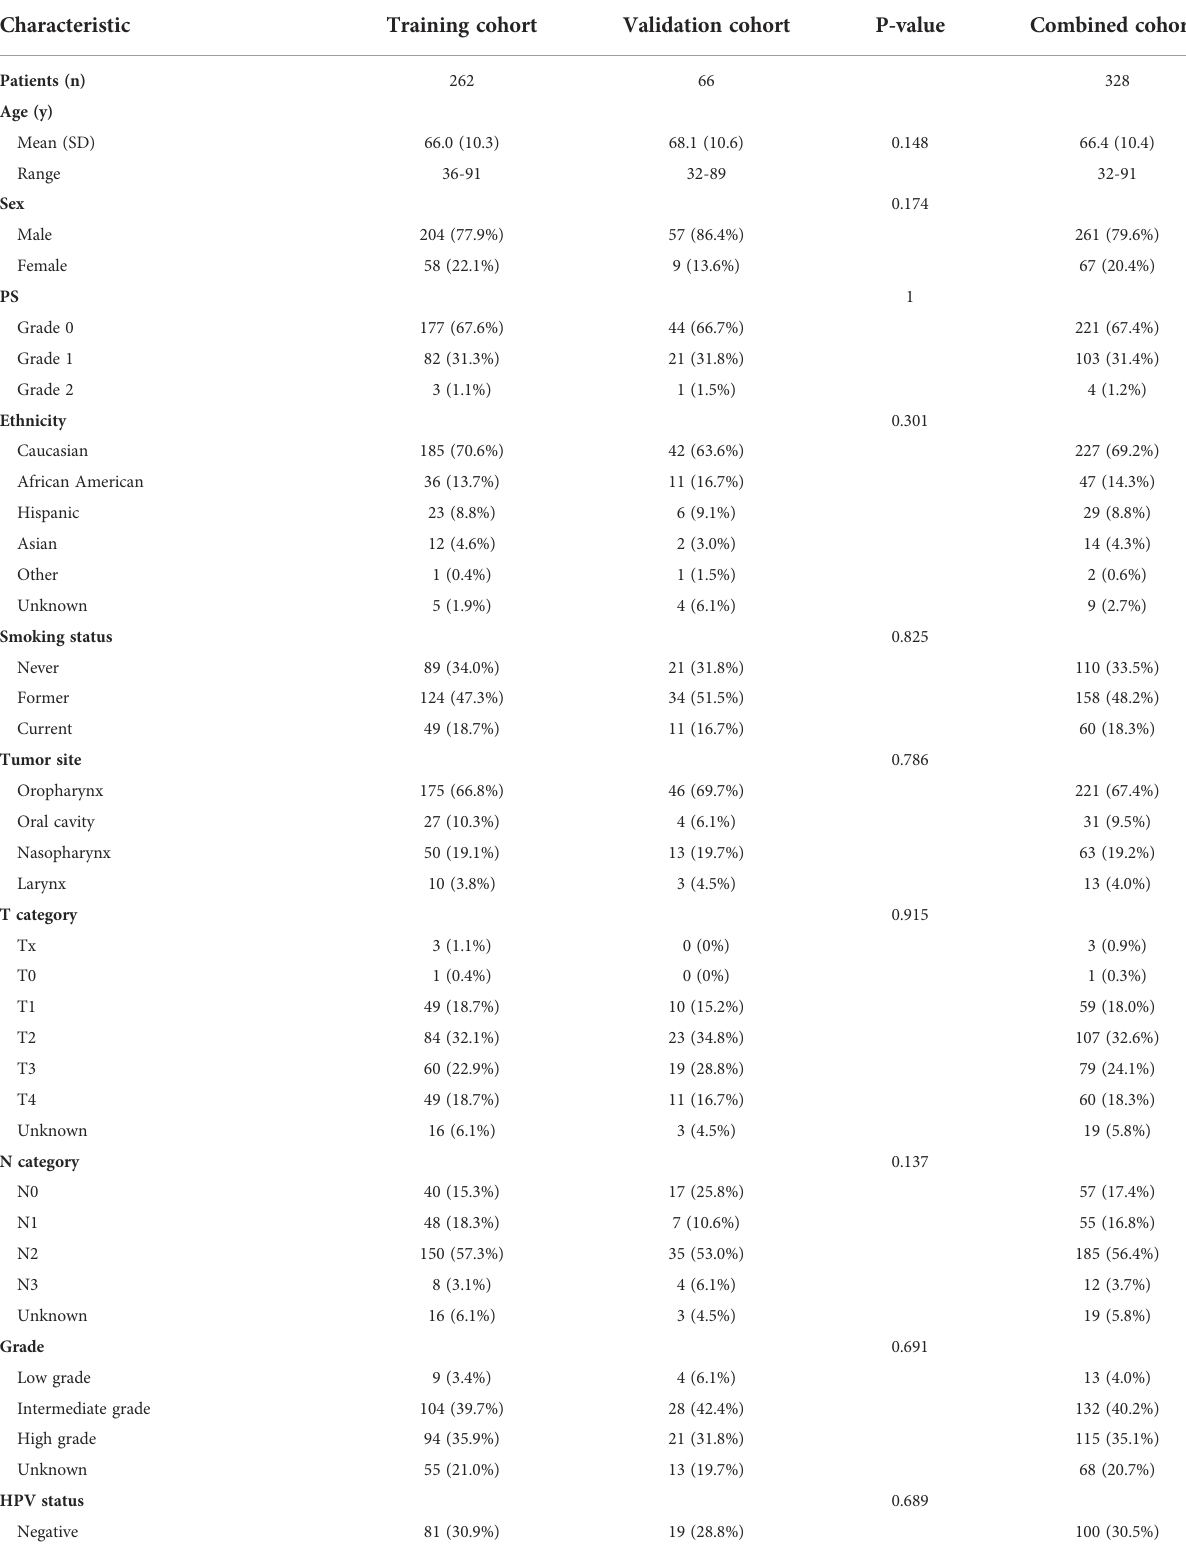
TABLE 1 Patient